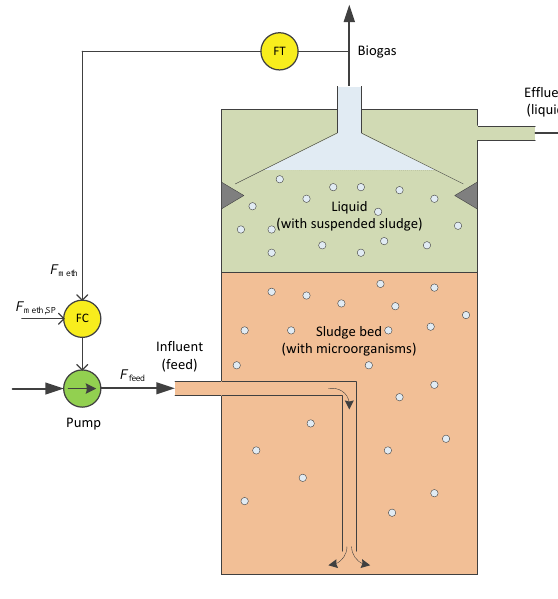
Figure 1: Methane flow control system.